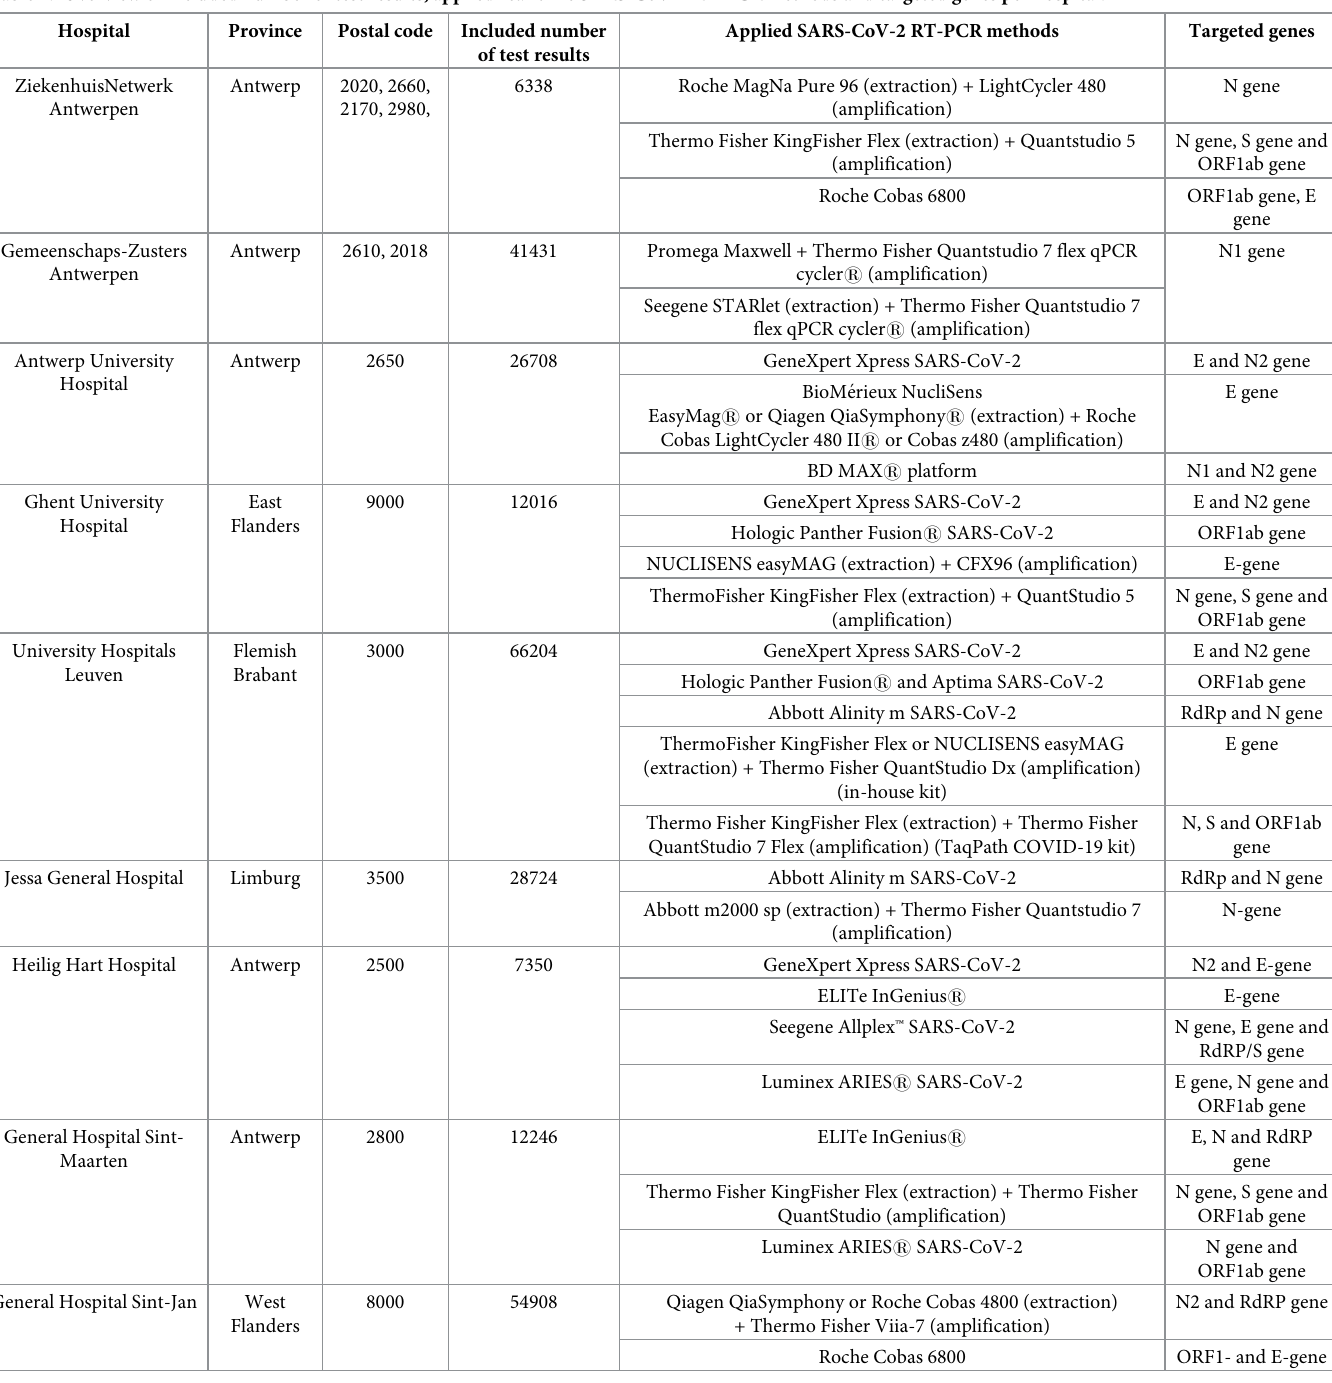
Table 1. Overview of included number of test results, applied real-time SARS-CoV-2 RT-PCR methods and targeted genes per hospital.